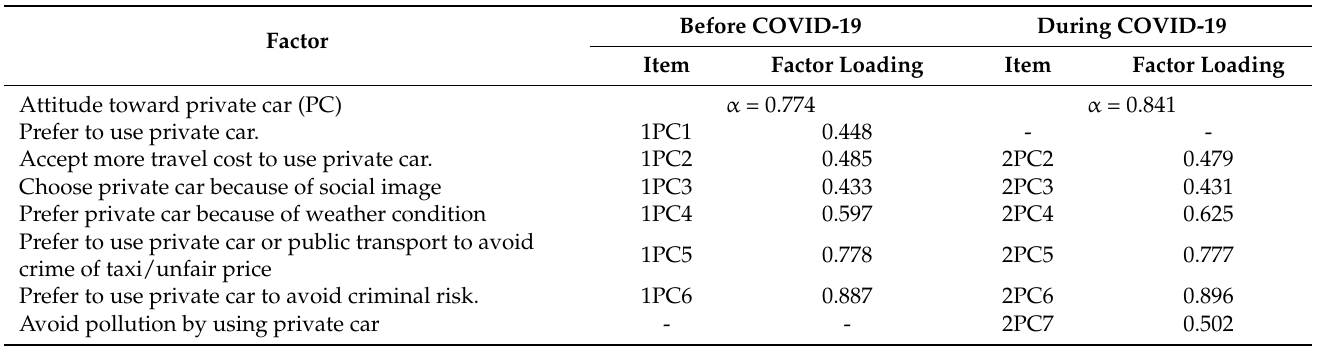
Table 3. Exploratory factor analysis